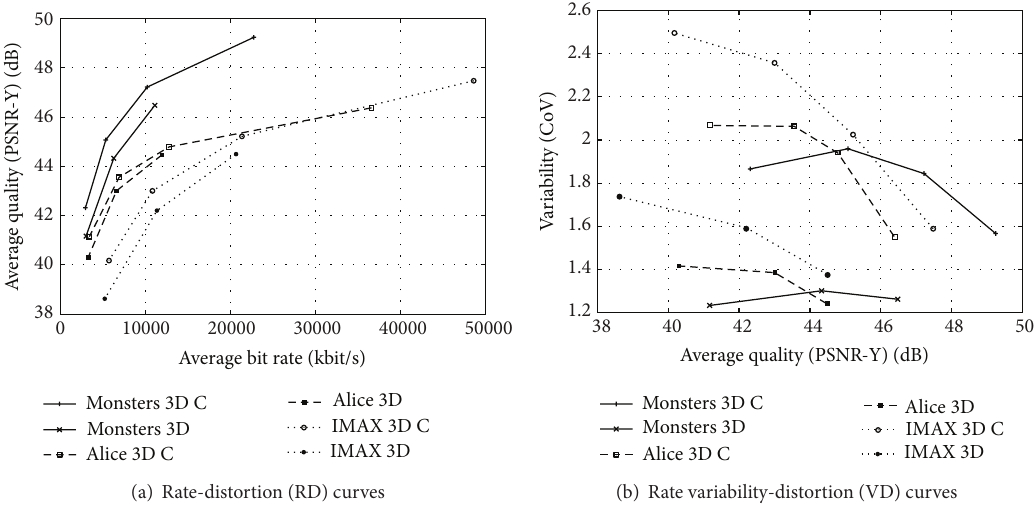
Figure 6: RD and VD characteristics of MVC encodings without and with cascaded QPs (C) of 35 minutes each of 3D videos Alice in Wonderland and IMAX Space Station with full HD 1920 × 1080 pixel resolution. The encoded left and right views are streamed sequentially (S) or are streamed aggregated (A) into multiview